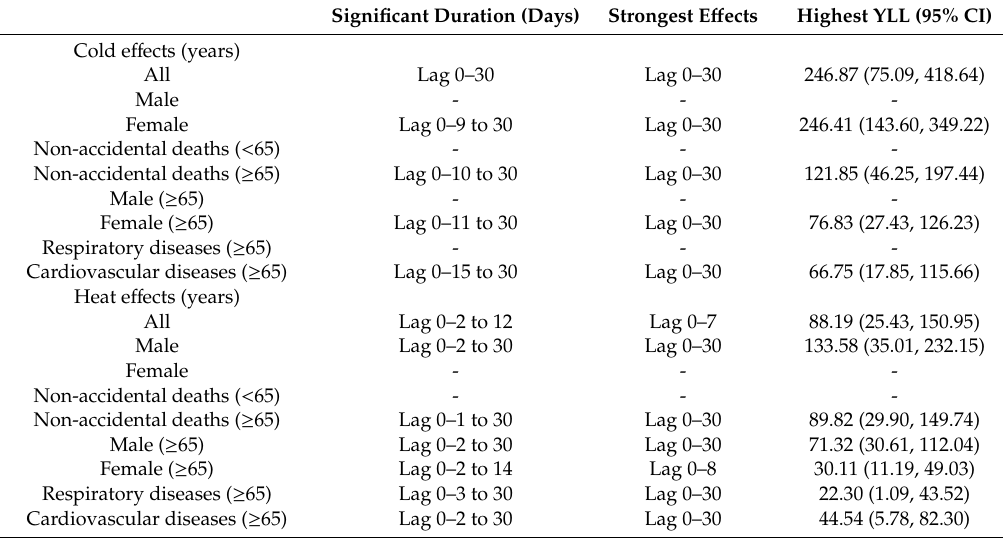
Table 3. Significant durations and strongest cumulative lag e ff ects of cold and heat for various subgroups in Lanzhou